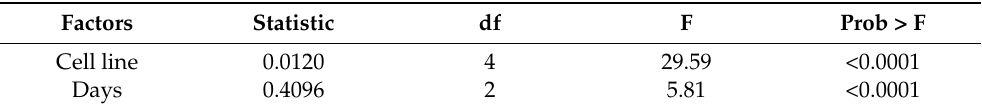
Table 2. MANOVA statistical results for comparing multiple variables jointly with respect to cell line and day factors.